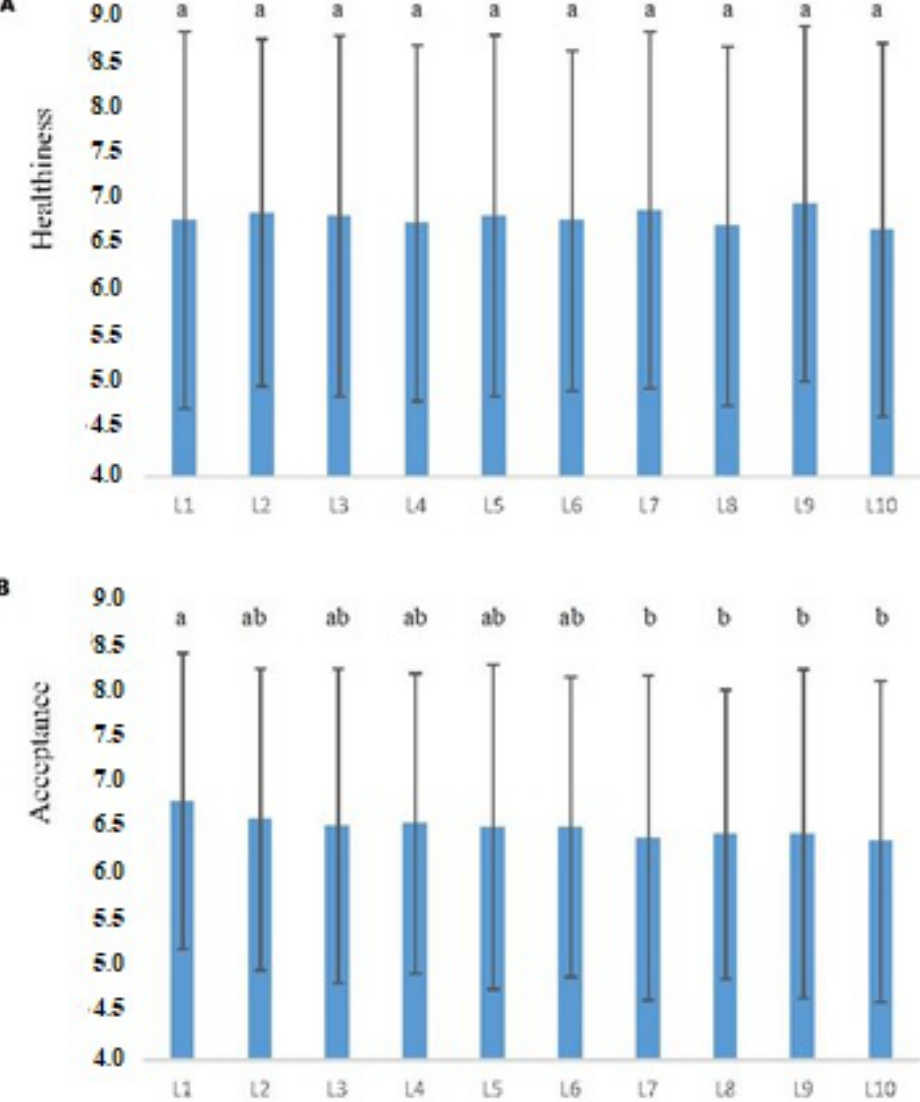
Figure 4. Mean as a Function of the color of the label and the type of sweetener. ( A ) Healthiness and ( B ) Acceptance. Error Bars Represent Standard Errors. Means with common letters indicate that there is not a significant difference between samples ( p < 0.05) from Tukey’s Honestly Significant Difference procedure (HSD). Samples: L1 (Orange color label with sweeteners), L2 (White color label with sweeteners), L3 (Yellow color label with sweeteners), L4 (Blue color label with sweeteners), L5 (Green color label with sweeteners), L6 (Orange color label with sucrose), L7 (White color label with sucrose), L8 (Yellow color label with sucrose), L9 (Blue color label with sucrose), L10 (Green color label with sucrose) (X-axis). The scale from 0 to 9 was limited to 4 for better visualization (Y-axis). Regarding the expected acceptance, the R1 label (orange color sweetened with ste- via/thaumatin sweeteners) did not differ statistically ( p > 0.05) from the R6 label (orange color sweetened with sucrose). However, the expected acceptance of the R1 label was sig- nificantly higher ( p < 0.05) when compared to four of the five labels that contained sucrose (white, yellow, blue and green) (M = 6.78 versus 6.51, 6.39, 6.43, 6.43 and 6.35 respectively; Figure 4B). Information about a reduction in ingredient content related to expected sen- sory characteristics influences hedonic expectations of consumers [42]. In the case of this study, the information “without added sugar” presented on labels with stevia/thaumatin sweeteners influenced the expectation of consumers, consistent with previous studies that state that products that contain a claim of “no added sugar” are generally preferable, as it refers to something more natural [43]. With increasing consumer interest in the negative effects of excess sugar on the human diet, information on sugar content (reduced or with- out) can have a positive effect on consumer expectations. Color of label also appears to have influenced consumer expectations. Because the color of the yogurt mentioned on the label refers to orange (which is the color of mango fruit), consumers possibly preferred the label more associated with the color that the prod- uct would have. This is due to the fact that consumer expectations are generated through